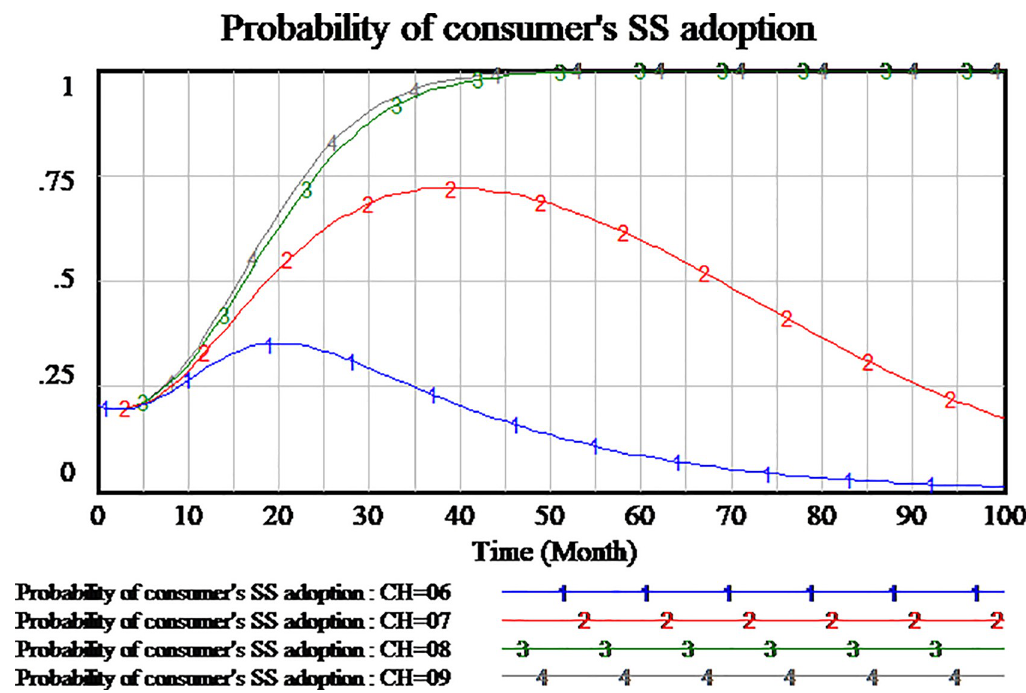
Fig 16. Impact of different cost of high-quality service on consumer.